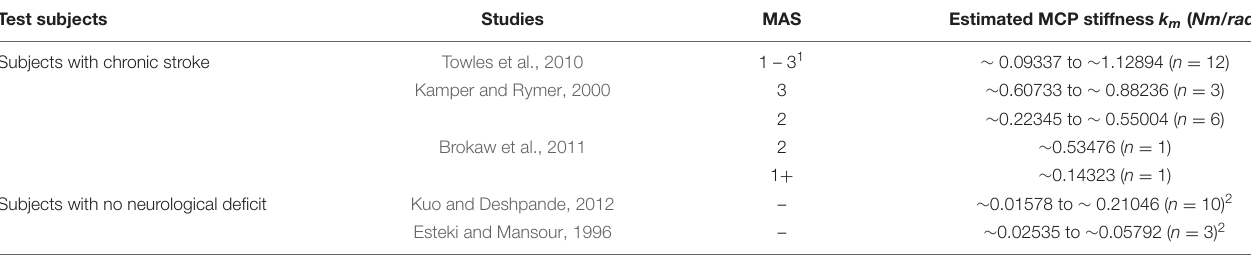
TABLE 4 | Existing studies about the quantification of MCP joint stiffness on both subjects with chronic stroke and no neurological